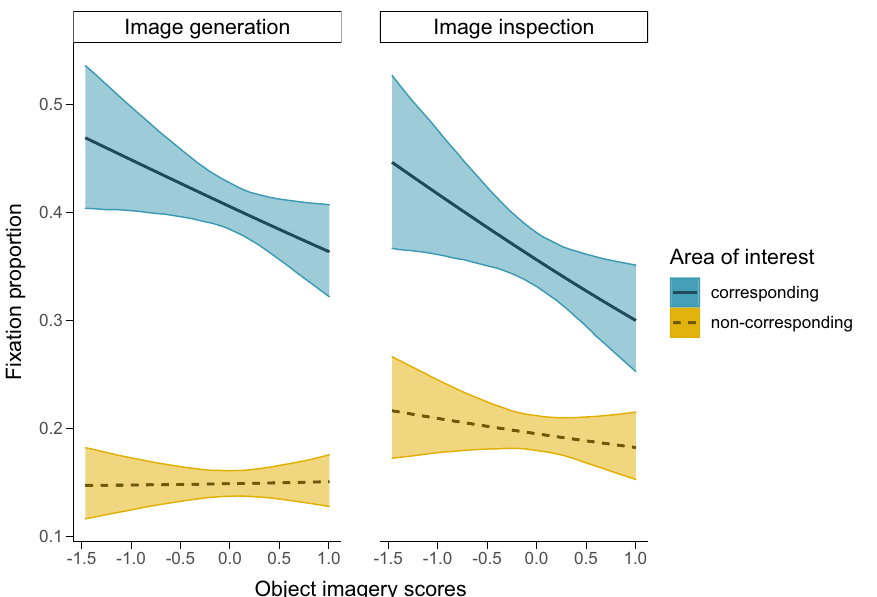
Figure 2. Posterior means and 95% credible intervals for the estimated fixation proportion per stimulus as a function of area of interest, task and object imagery scores (centered around the grand